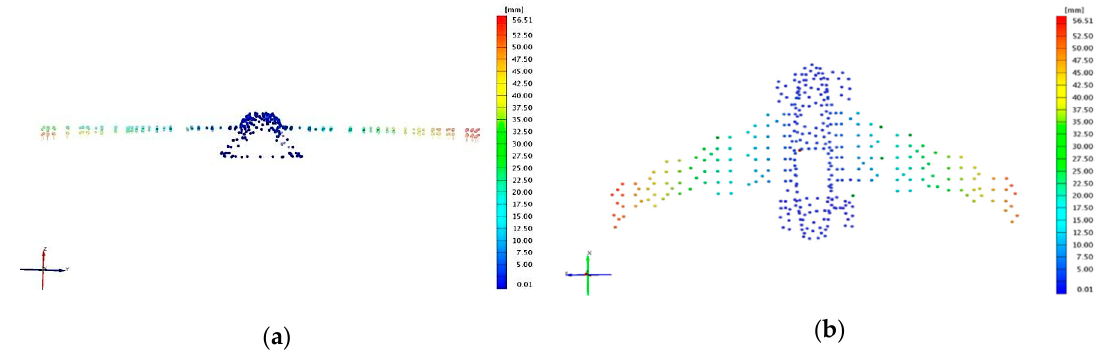
Figure 19. Comparison of structure displacements for nz = 1 and nz = 5 in the ( a ) horizontal and